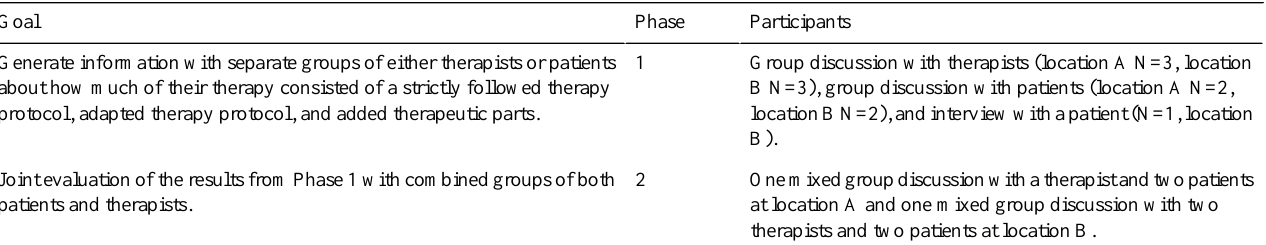
Table 1. Setup of the focus group sessions with therapists and patients on protocol application and personalization. ParticipantsPhaseGoal